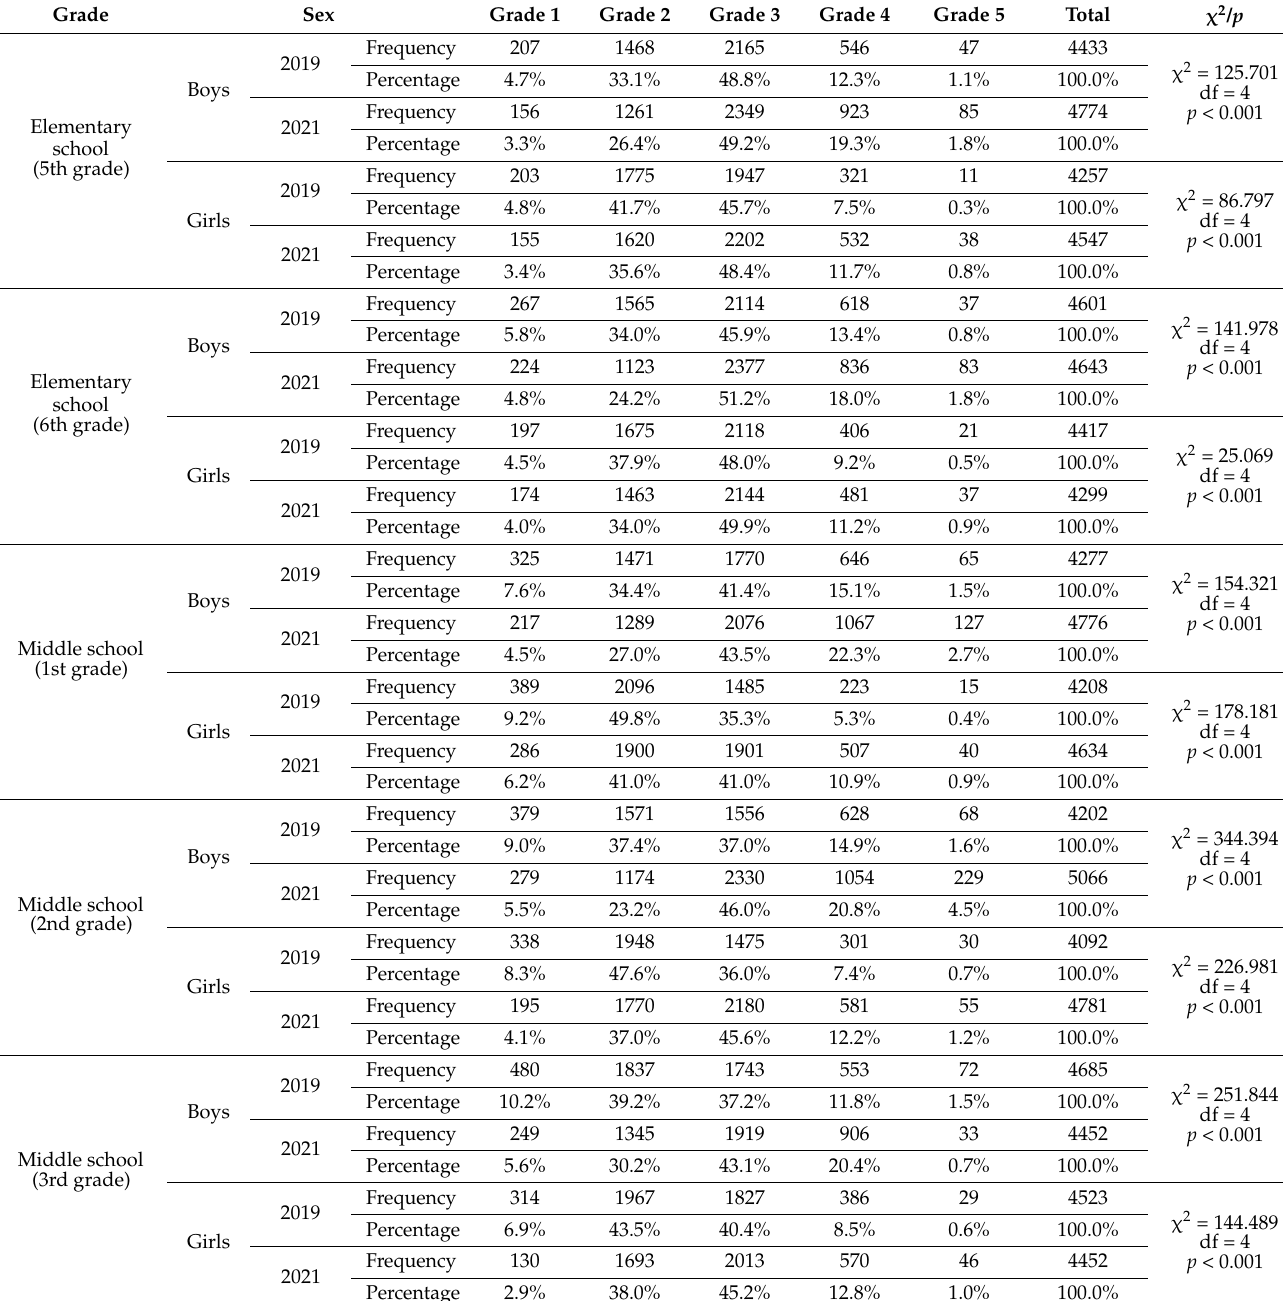
Table 8. Comparison of overall health-related physical fitness in 2019 and